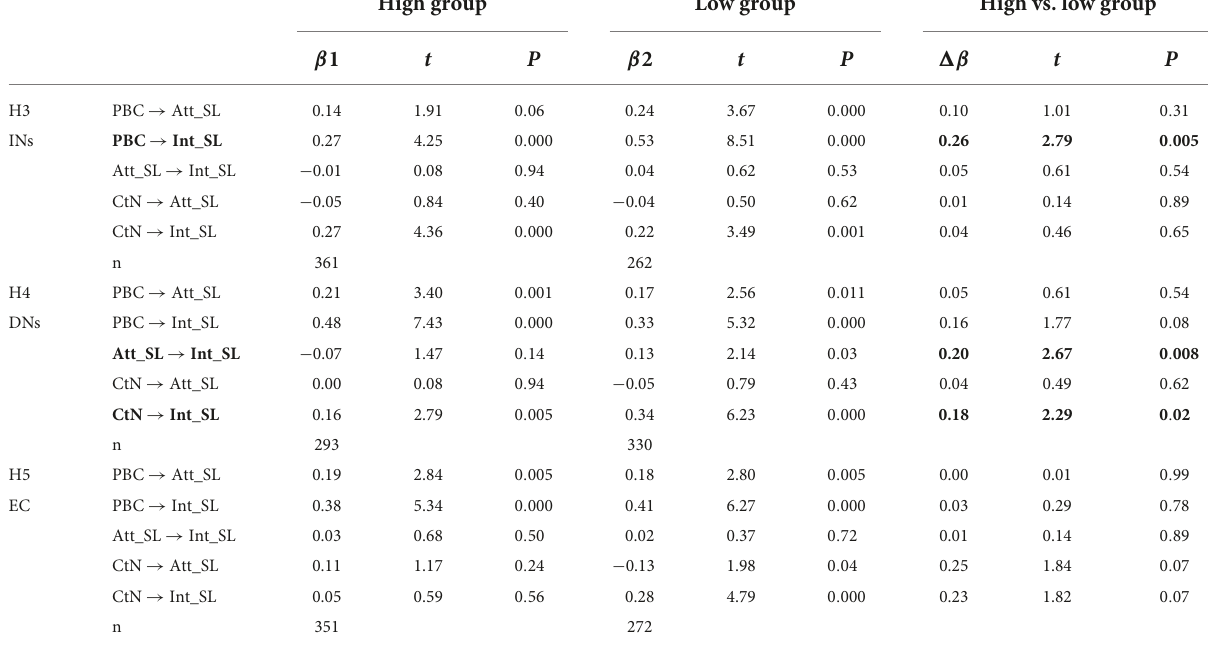
TABLE 4 Results of multi-group